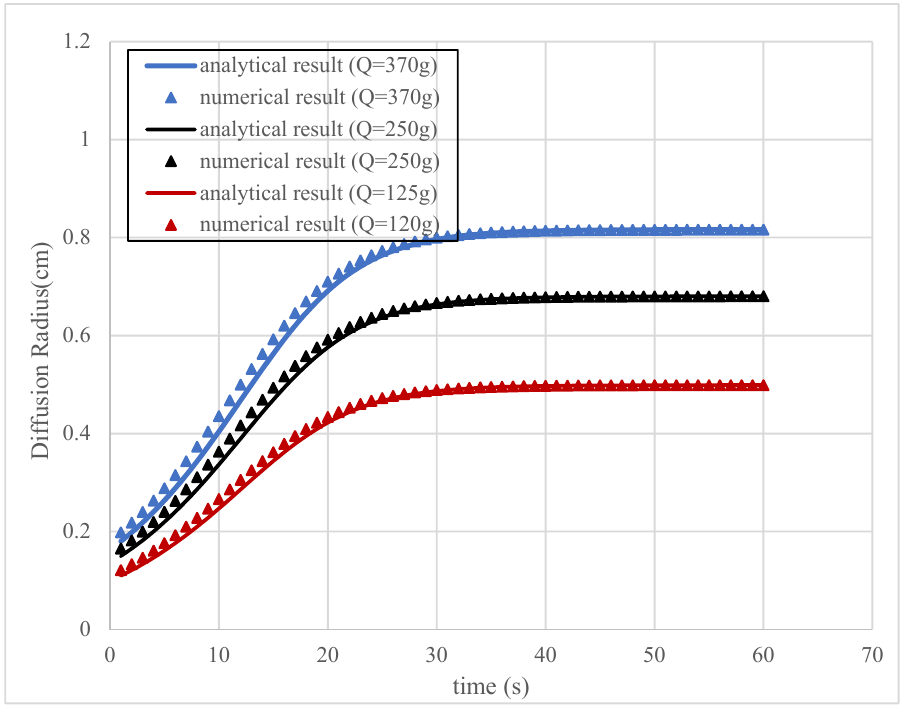
Figure 6. Variation curve of diffusion radius with time under different grouting amounts.